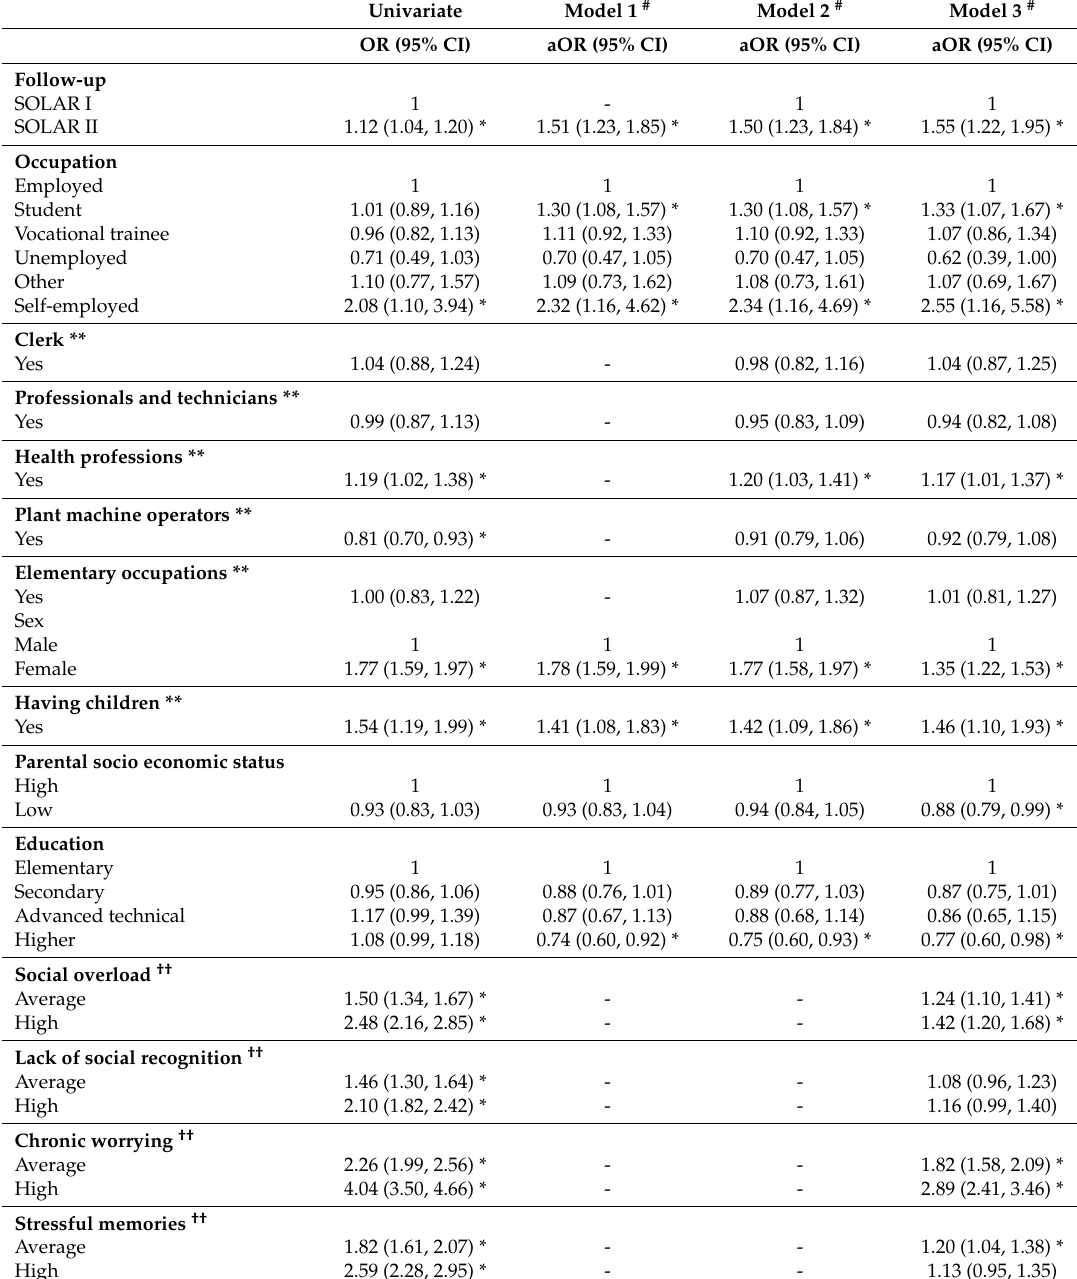
Table 2. Unadjusted (OR) and adjusted odds ratios (aOR) after multiple imputation with 95% confidence intervals (95% CI) for work overload using ordinal generalized estimating equation (GEE) models in a prospective cohort of 1688 young adults in Germany. Univariate Model 1 # Model 2 # Model 3 # OR (95% CI) aOR (95%